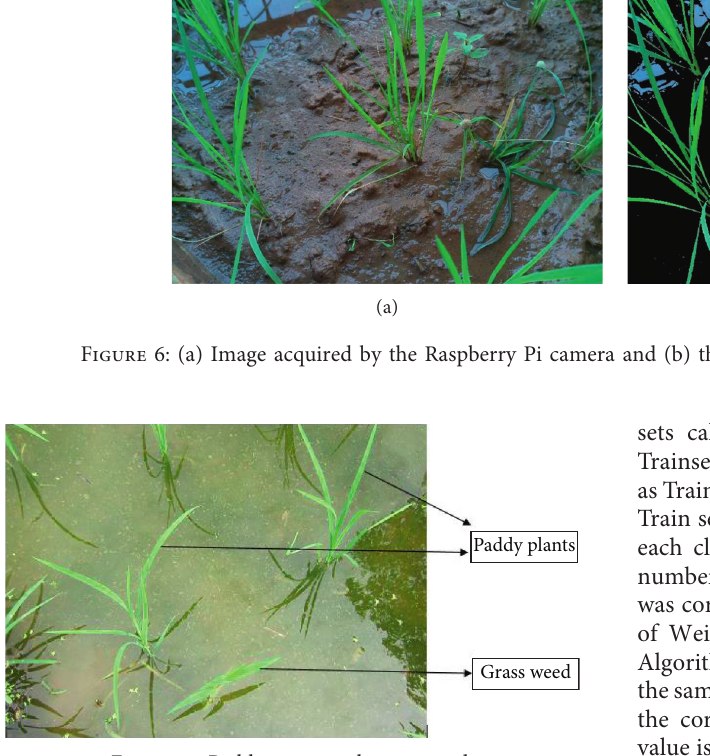
Figure 7: Paddy crops and grass